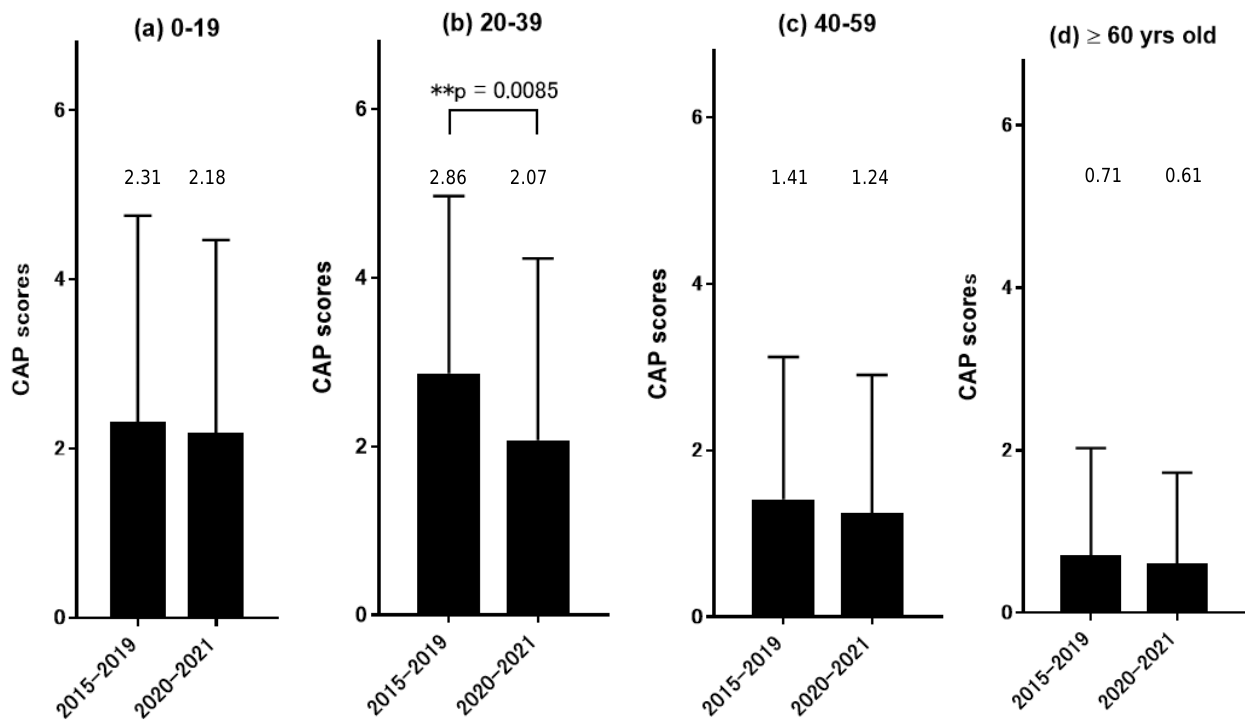
Figure 3. Comparison of CAP scores for house dust in each age group between the pre-COVID-19 (2015–2019) and COVID-19 (2020–2021) eras. ( a ) 0–19, ( b ) 20–39, ( c ) 40–59, ( d ) ≥ 60 years old groups. The data are mean ± SD (error bars). ** p <